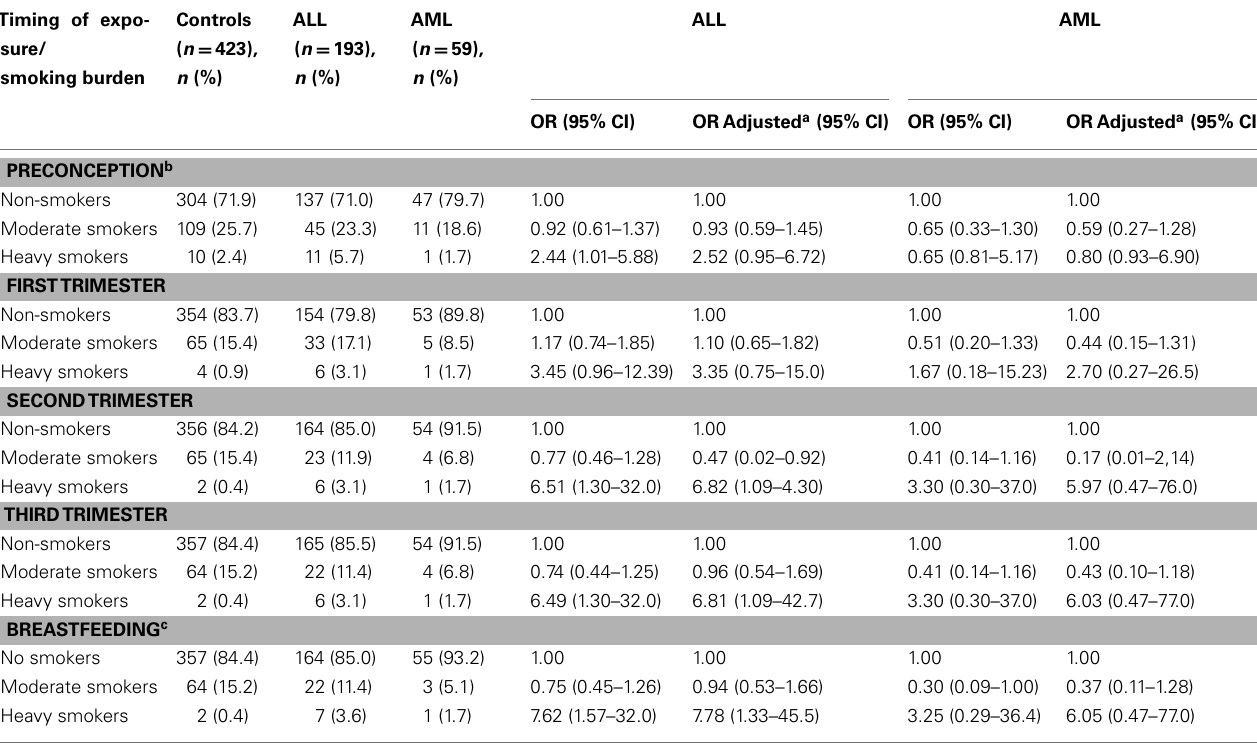
Table 4 | Maternal smoking by tobacco consumption burden, leukemia cases, and control mothers, children < 2year, Brazil,